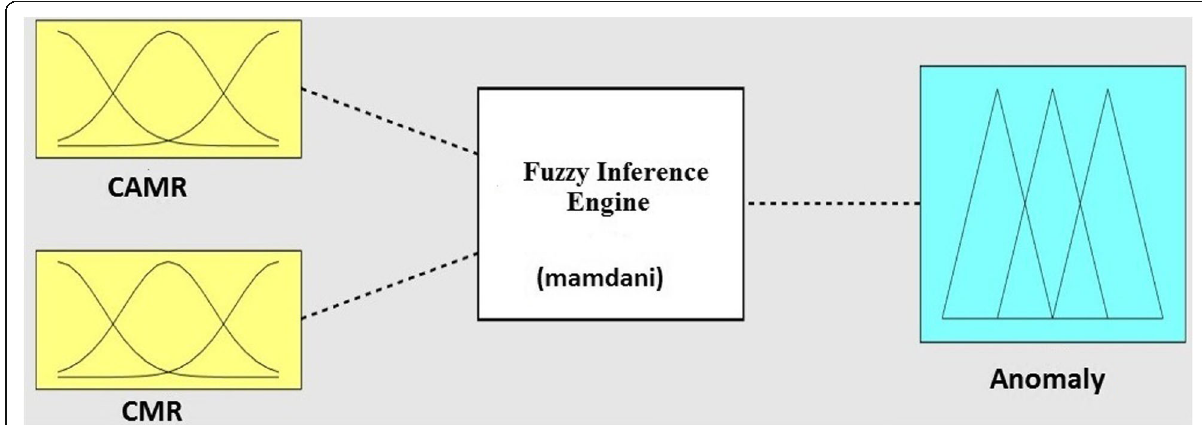
Fig. 8 Proposed Fuzzy Inference